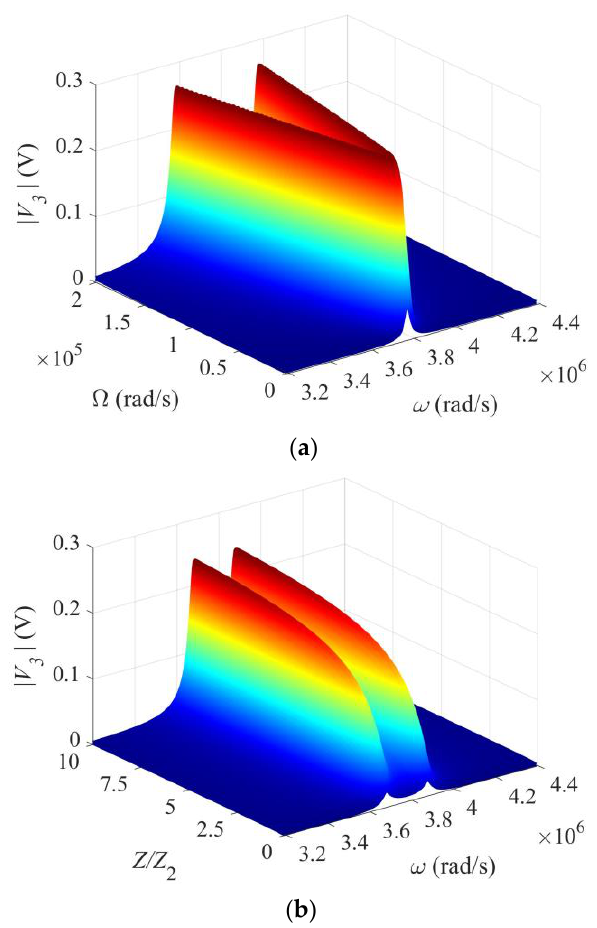
Figure 4. Three-dimensional views of the output voltage. ( a ) V 3 versus ω and Ω. Z = ∞. ( b ) V 3 versus ω and Z . Ω = 10 5 rad/s.